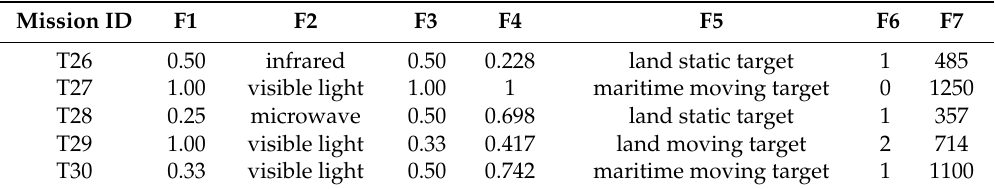
Table 8. Information of priority impact factors for newly arrived missions.